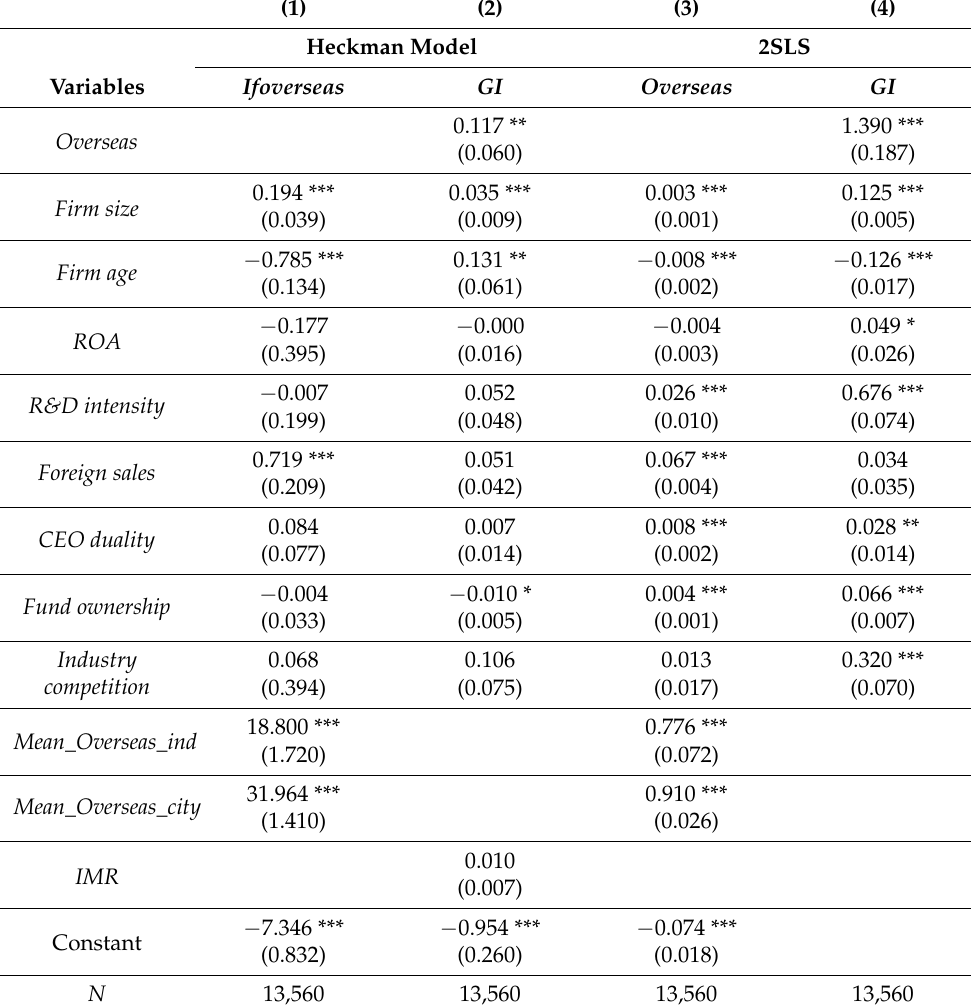
Table 7. Robustness checks: 2-stage Heckman model and